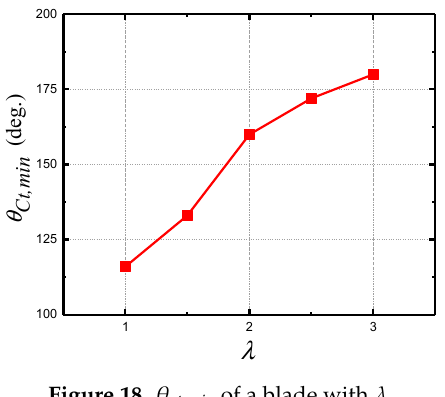
Figure 18. θ ct.mix of a blade with λ .